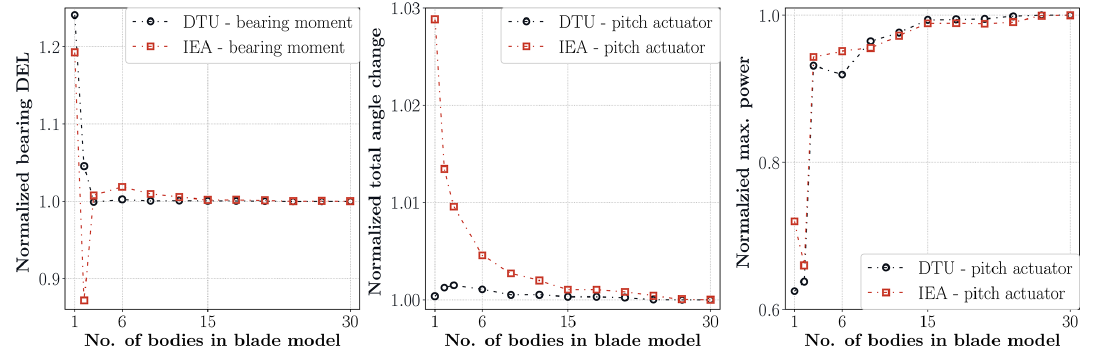
Figure 13. Normalized blade pitch actuator (blade root torsion moment) DEL, total pitch angle change for all load cases and maximum power at pitch actuator with respect to number of blade sub-bodies.